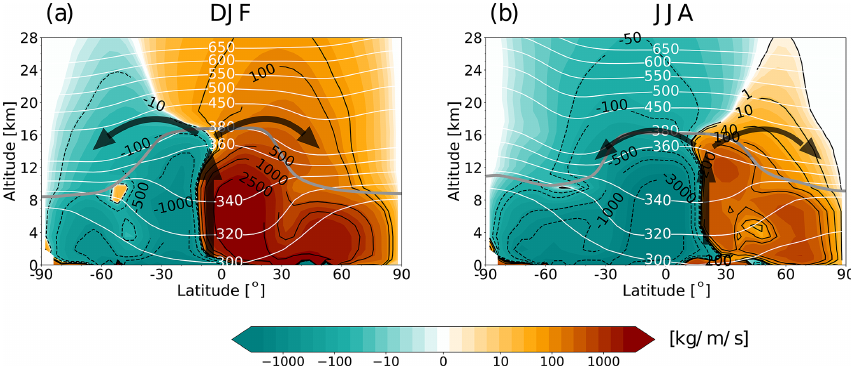
Figure 2. Climatology (1999–2017) of the residual mean mass streamfunction (color shading with a subset of values highlighted in black contours). The grey line shows the WMO tropopause. White contours show potential temperature levels in kelvin. The thick black arrows illustrate the upwelling of the Hadley circulation and the shallow branch of the BD circulation (around 400K).